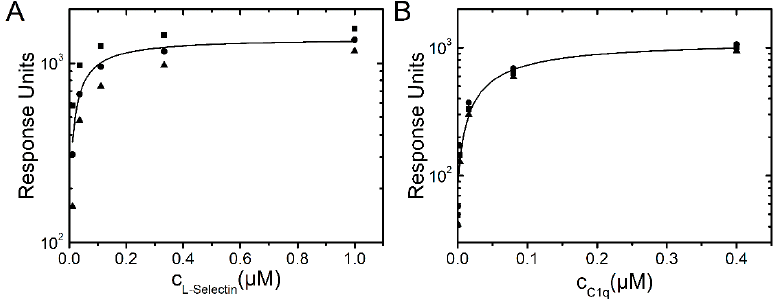
Figure 7. Langmuir binding isotherms of L-selectin ( A ) and C1q ( B ) to dPGS.